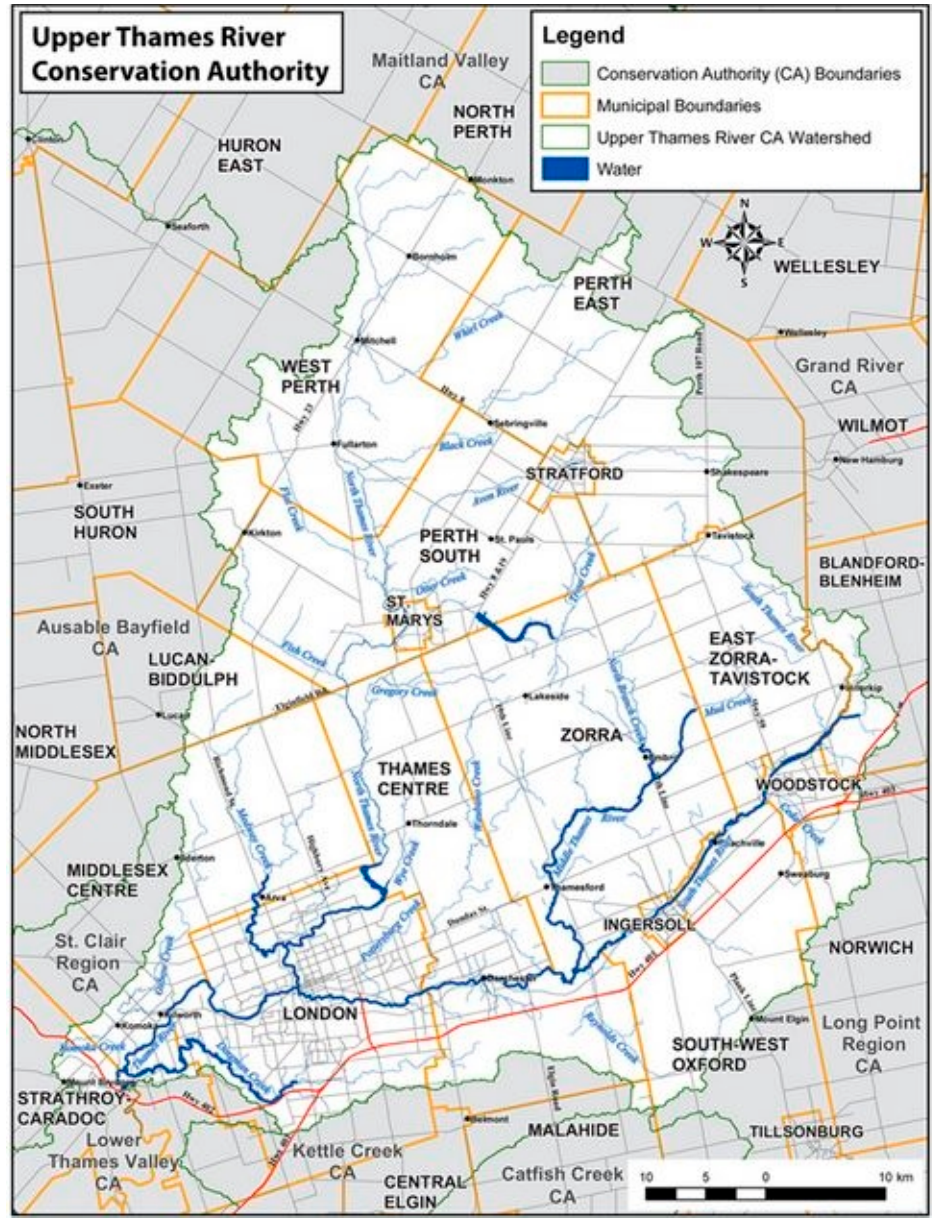
Figure 11. Map of the Upper Thames River Watershed (http://thamesriver.on.ca/, accessed on January 2016).